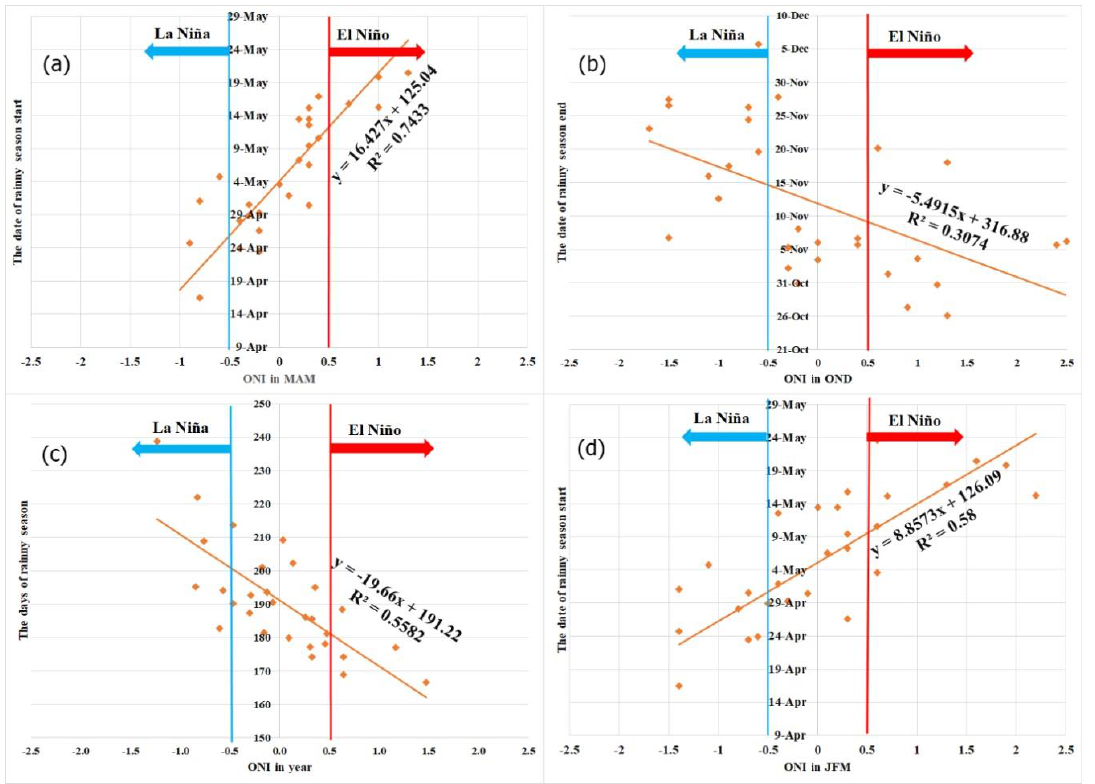
Figure 5. Relationship between ONI and rainy season characteristics: ( a ) relationship between ONI in April and the rainy season start date, ( b ) relationship between ONI in November and the end of the rainy season, ( c ) the relationship between the average annual ONI and the length of the rainy season, and ( d ) the relationship between ONI in February and the start date of the rainy season.